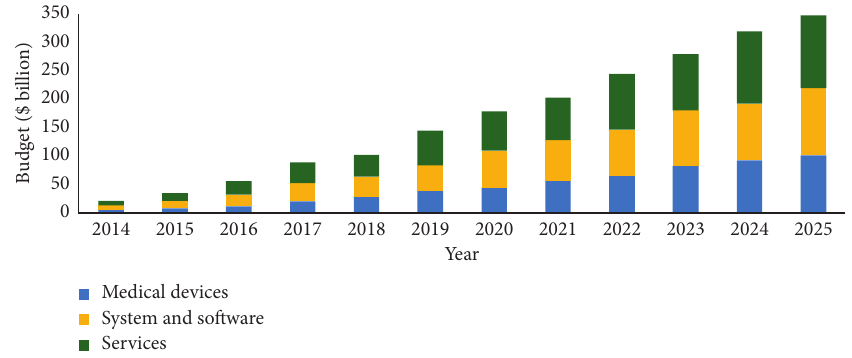
Figure 2: North America IoT in healthcare market (2014–2025).